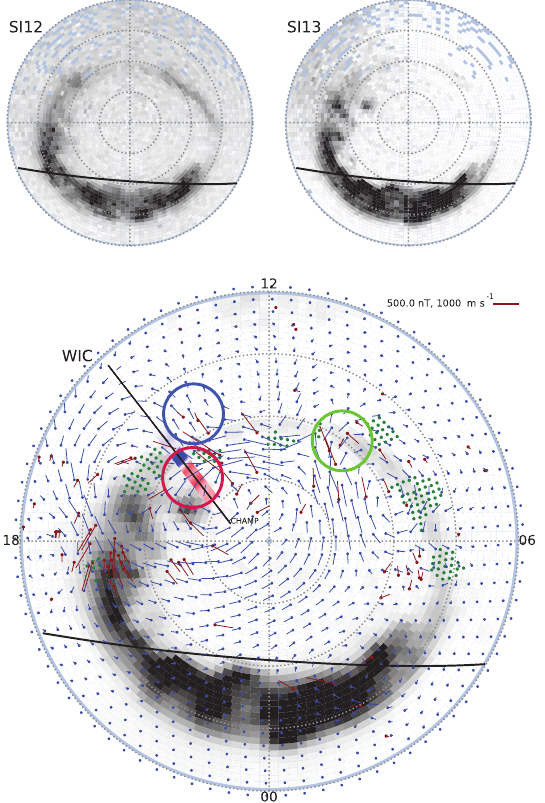
Figure 14. Auroral images from the Northern Hemisphere at 16:31UT, 17 August 2001. (a) SI12, (b) SI13 and (c) WIC with derived currents from CHAMP pass. Red (blue) is upward (down- ward) currents. The green dots indicate locations of SuperDARN backscatter. SuperMAG equivalent currents are shown with brown vectors. The scale of the convection and magnetic field perturba- tions are shown in the top right corner of the WIC image. The loca- tion of the sunlight terminator is indicated by a black line. Derived convection patterns are shown by blue vectors. The three circles mark the flows discussed in the text.